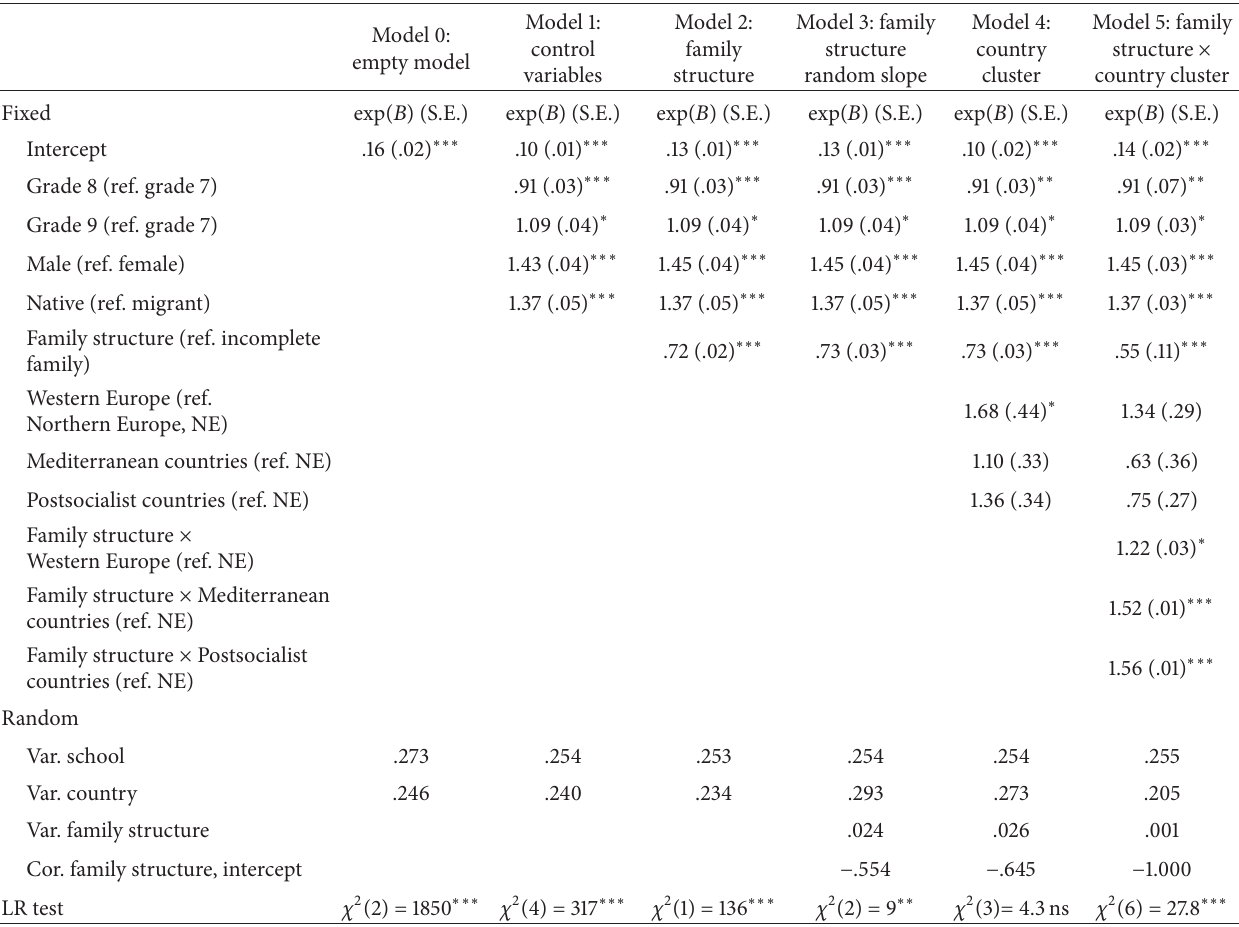
Table 2: The results of multilevel analysis concerning family structure ( 𝑛 individuals: 53053; 𝑛 schools: 1344; 𝑛 countries: